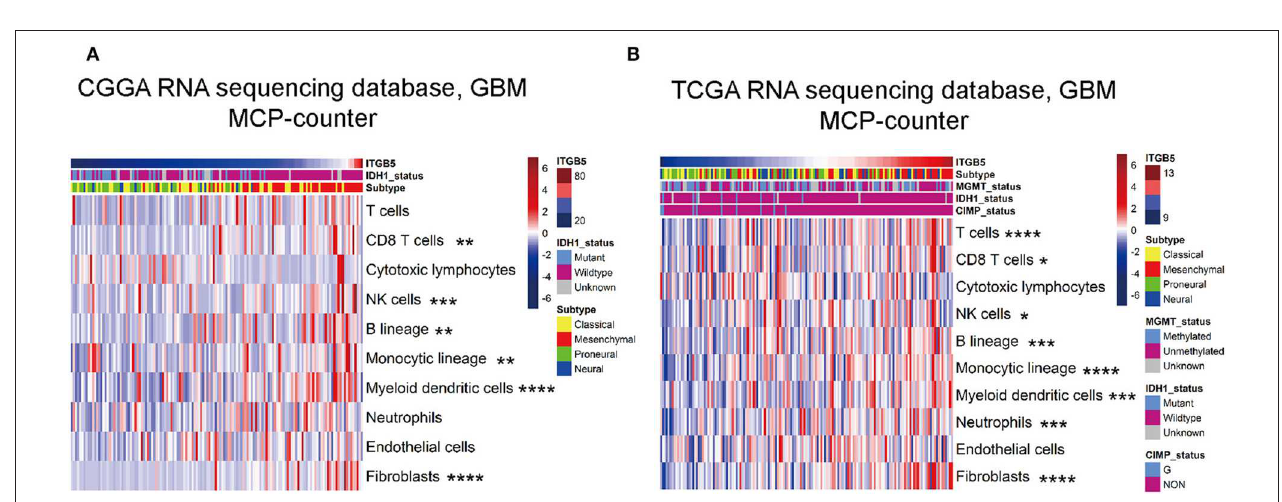
FIGURE 6 | Correlation between ITGB5 expression and non-tumor immune and stromal cell populations in the GBM microenvironment. Cell populations were quantified with MCP-counter ( A , CGGA GBM RNAseq; B , TCGA GBM RNAseq). * P < 0.05; ** P < 0.01; *** P < 0.001; **** P < 0.0001 (Pearson’s correlation analysis). stromal scores in CGGA and TCGA datasets ( r > 0.45 or